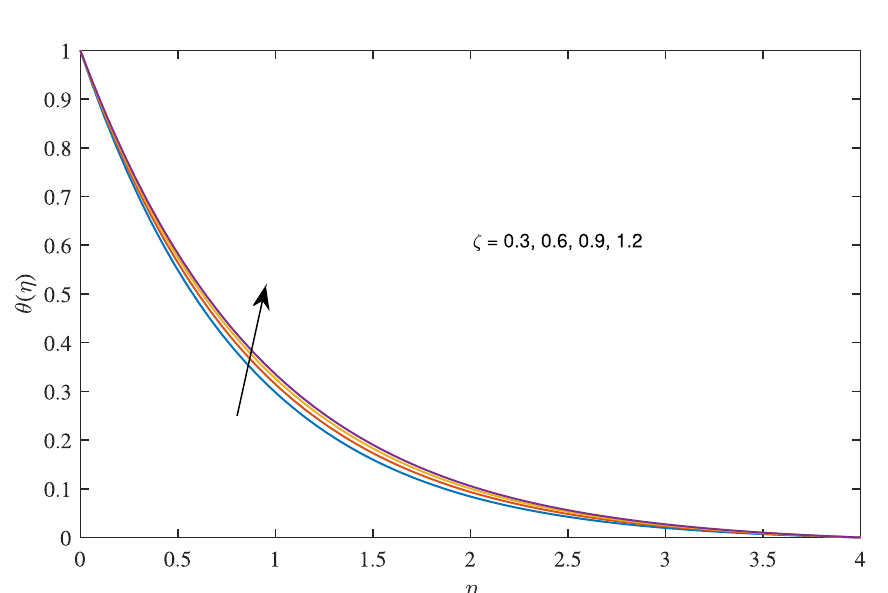
Figure 11. Effects of slip parameter ζ on radial velocity, when c 6.2 . Pr =